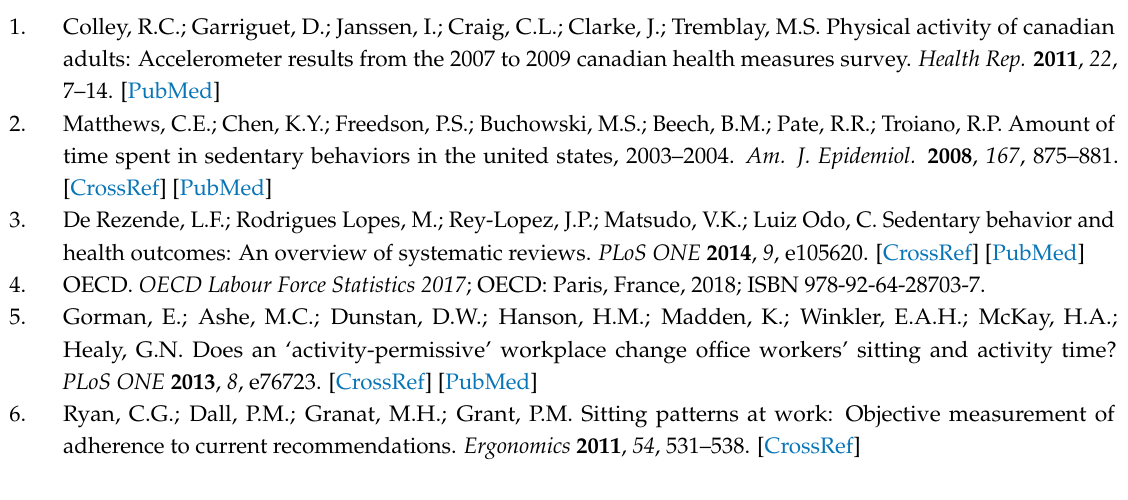
s1. Table S1: List of the first 20 features for each developed decision tree model; Figure S1: Decision Tree AUC-6 (sitting); Figure S2: Decision Tree AUC-11 (sitting); Figure S3: Decision Tree MCC-10 (sitting); Figure S4: Decision Tree AUC-5 (standing); Figure S5: Decision Tree AUC-8